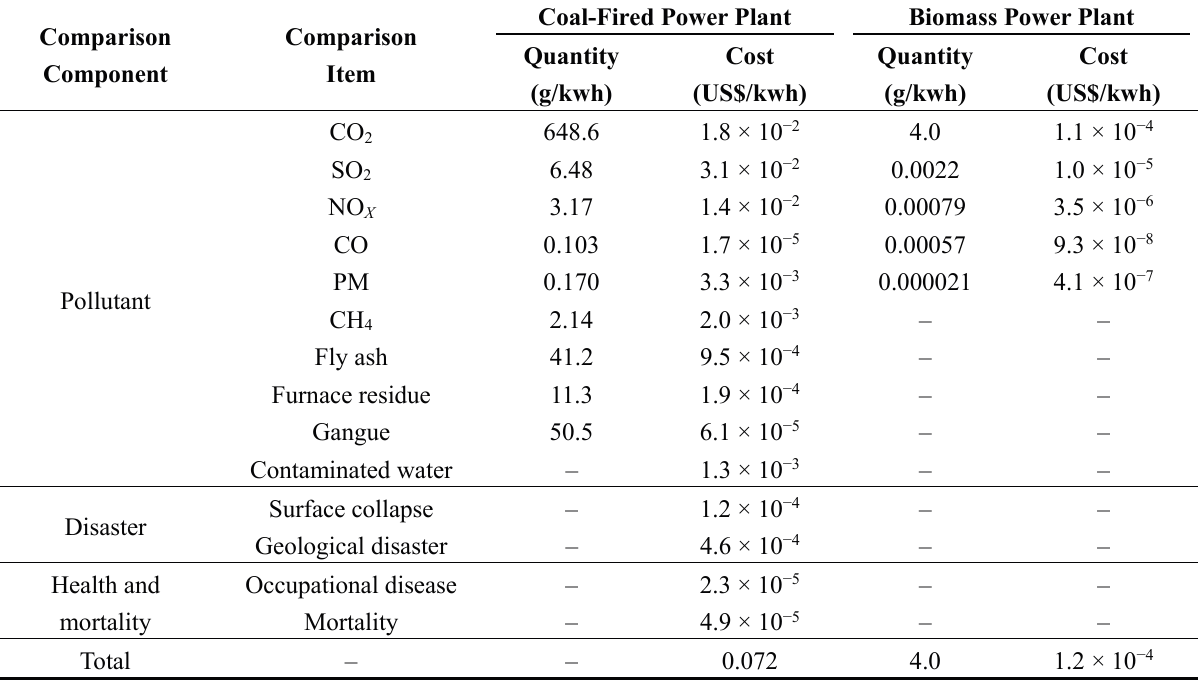
Table 10. Comparison of a 600 MW coal-fired power plant and a 30 MW biomass power plant.